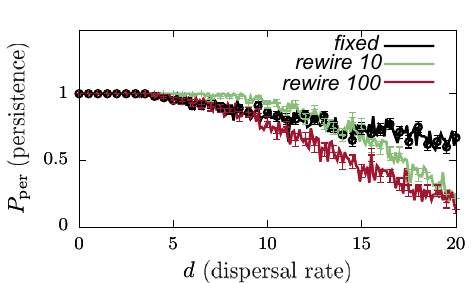
20 , as a function of dispersal rate d , and SE ( P per ) are highlighted by error bars Figure 5. P per estimates for N = every four data points, for identical patches with fixed (black) versus different rewiring rates—every 10 (green) 100 network realizations were used for these calculations. Corresponding and 100 (red) time units. N ensemble = biomass estimates are provided in Online Appendix Fig.